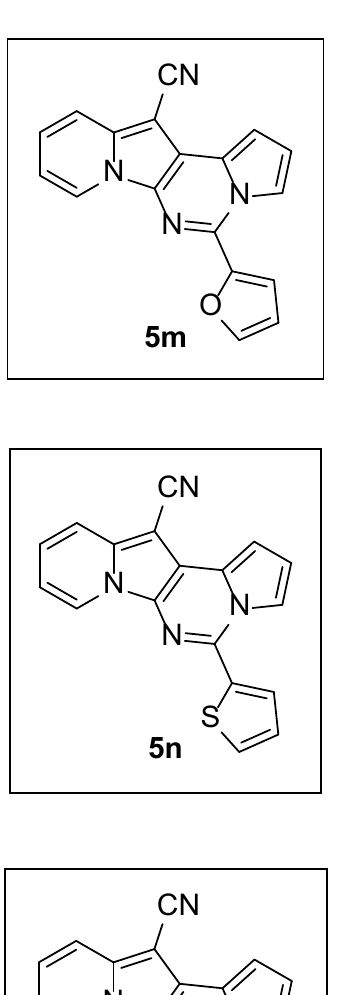
5-(Pyridin-3-yl)pyrrolo[1 (cid:48) ,2 (cid:48) :1,6]pyrimido[5,4- b ]indolizine-12-carbonitrile (5o). Yellow solid, m.p.: 238.3–238.9 ◦ C (30.6 mg, 90%); 1 H NMR (400 MHz, CDCl 3